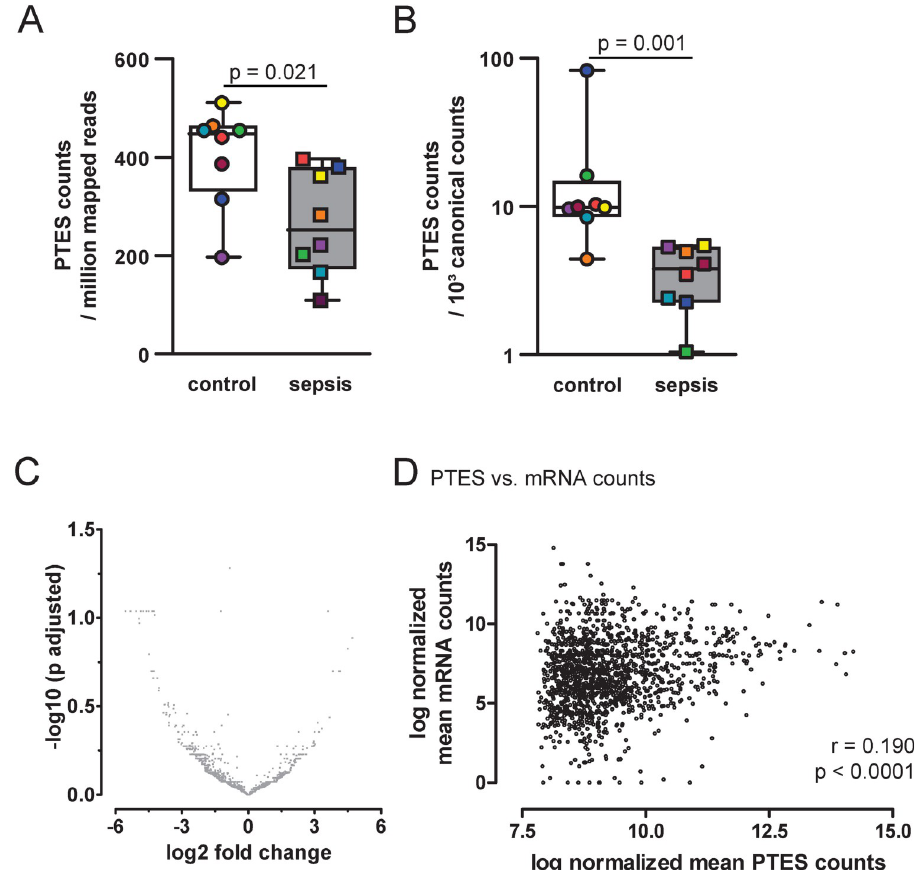
Fig 2. Analysis of post-transcriptional exon shuffling (PTES) transcripts. Comparison between control patients (transparent bars) and patients with sepsis (filled bars) in A and B. PTES transcripts or putative circular RNA transcripts were identified and normalised for each patient to (A) the overall number of mapped reads or (B) to the sum of canonical reads as identified by PTESfinder. Filling colour of data points indicates individual samples within the respective groups, boxes with inner line display interquartile range with median, whiskers minimum and maximum of values. P values from Mann-Whitney U test (C) Volcano plot of adjusted p values from differential expression analysis by edgeR versus log2 fold changes showing absence of significant differences between control patients and patients with sepsis. Note the different y-axis as compared to Fig 5. (D) Spearman correlation between mean mRNA expression and mean PTES expression levels. Note the off-set x-axis, limiting PTES counts to values > 8. Lower values were filtered out for low expression in differential expression analysis.